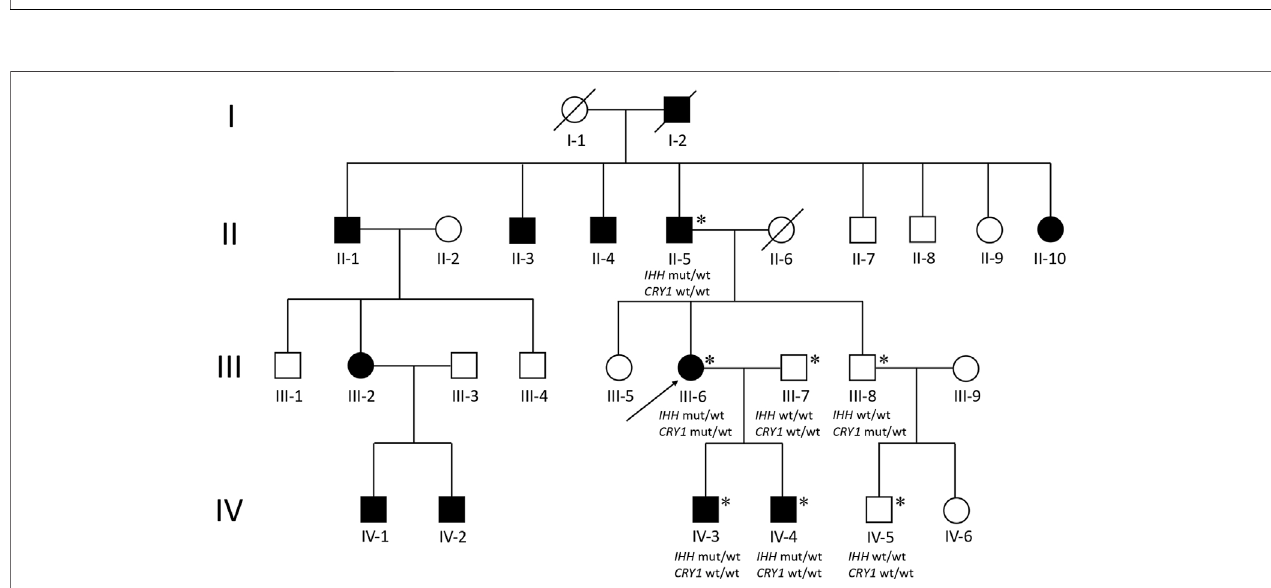
FIGURE 2 | Pedigree ofa four-generation family with BDA1. Filled symbols represent affected individuals; open symbols represent unaffected individuals; squares depict males, and circles depictfemales. Theproband isindicated byanarrow. Diagonal lines indicate the proband. Asterisks represent participants who participated in WES testing. Wt, wild type; mut,